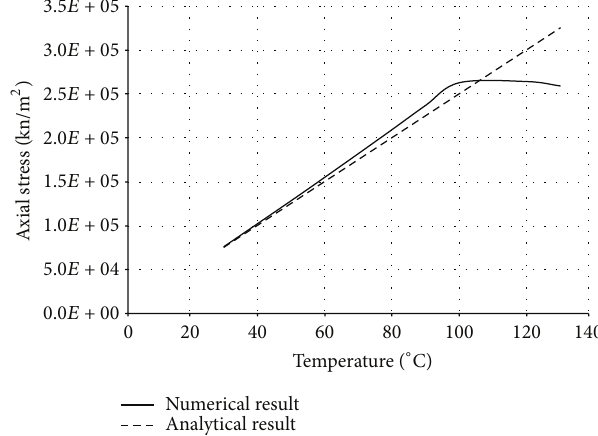
Figure 21: Comparison of axial stress in steel tube